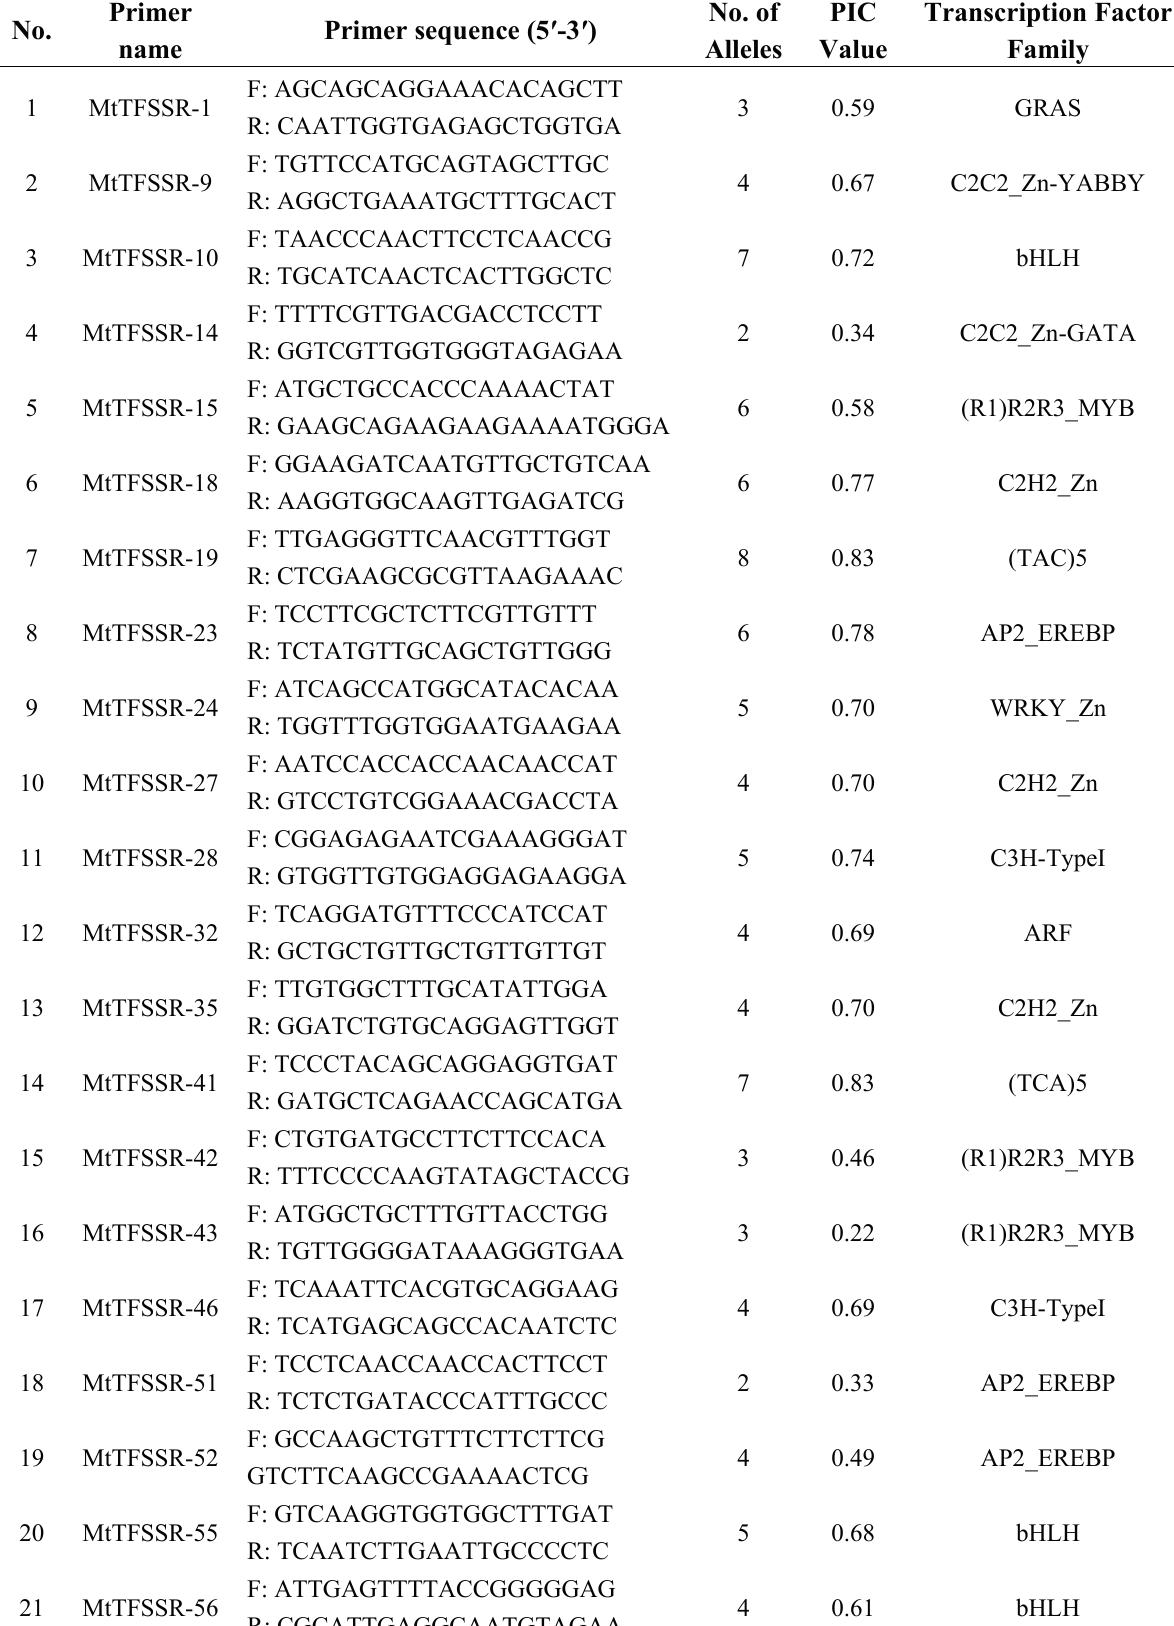
Primer sequence (5 ′ -3 ′ )